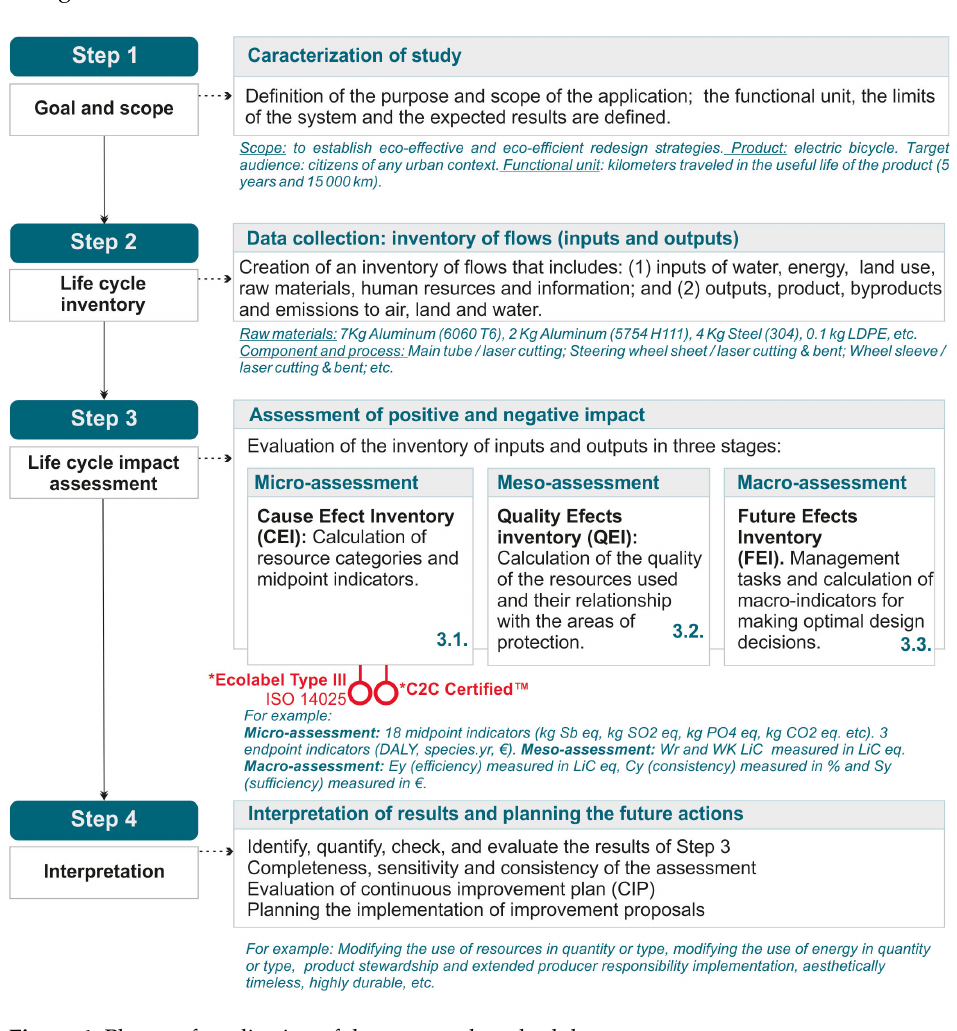
Figure 4. Phases of application of the proposed